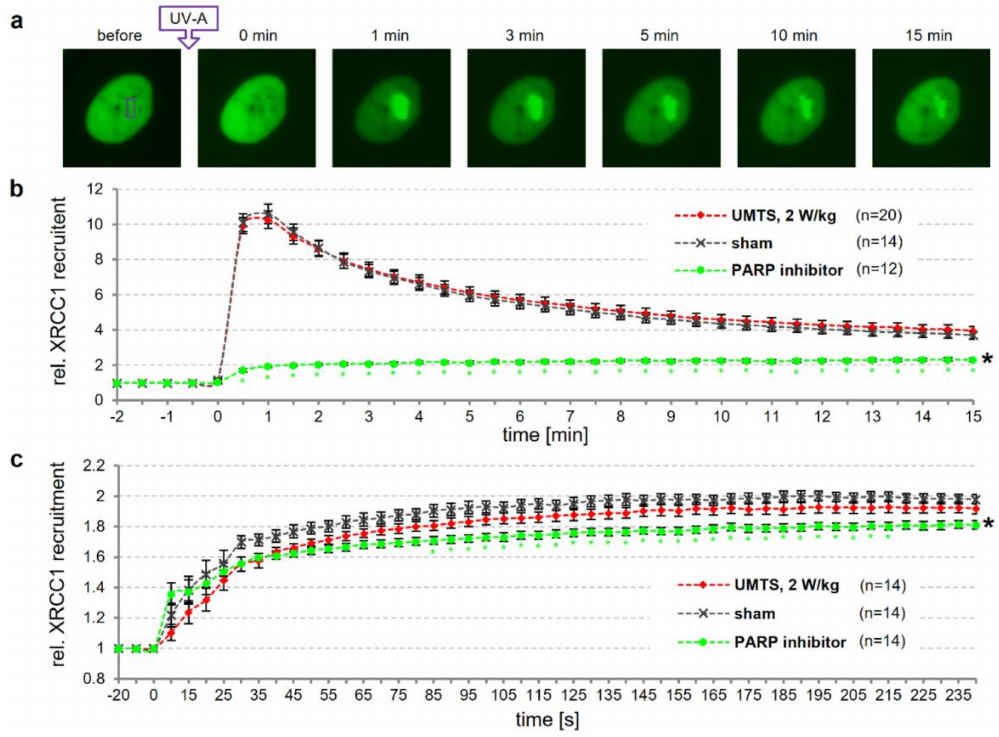
Figure 5. Dynamics of XRCC1 association with UV-A-induced DNA damage under sham or UMTS exposure. XRCC1-GFP expressing U-2 OS cells were sham- or pre-exposed with continuous 2 W / kg UMTS signal (t > 15 min) before induction of DNA damage by a UV-A laser in a pre-defined nuclear region (rectangle). Recruitment of XRCC1 to sites of DNA damage was recorded by live cell imaging. ( a ) Representative images of time-dependent XRCC1 recruitment. ( b , c ) Automated quantitation of XRCC1 recruitment (ratio median pixel intensities of DNA damage site and nucleus) to sites of high ( b ) and low ( c ) dose of DNA damage (duration of micro-laser irradiation) monitored for 15 and 4 min, respectively. As a control for altered BER / SSBR dynamics, cells were pre-incubated with 5 µ M of the PARP inhibitor AG-014699. Error bars represent SEM of standardized XRCC1 signals of n = 12–20 analyzed nuclei, pooled from four independent experiments. Black and colored asterisks mark significant di ff erences ( p ≤ 0.05), compared to sham-exposed cells by two-way ANOVA and post-hoc Bonferroni test for matched time-points,